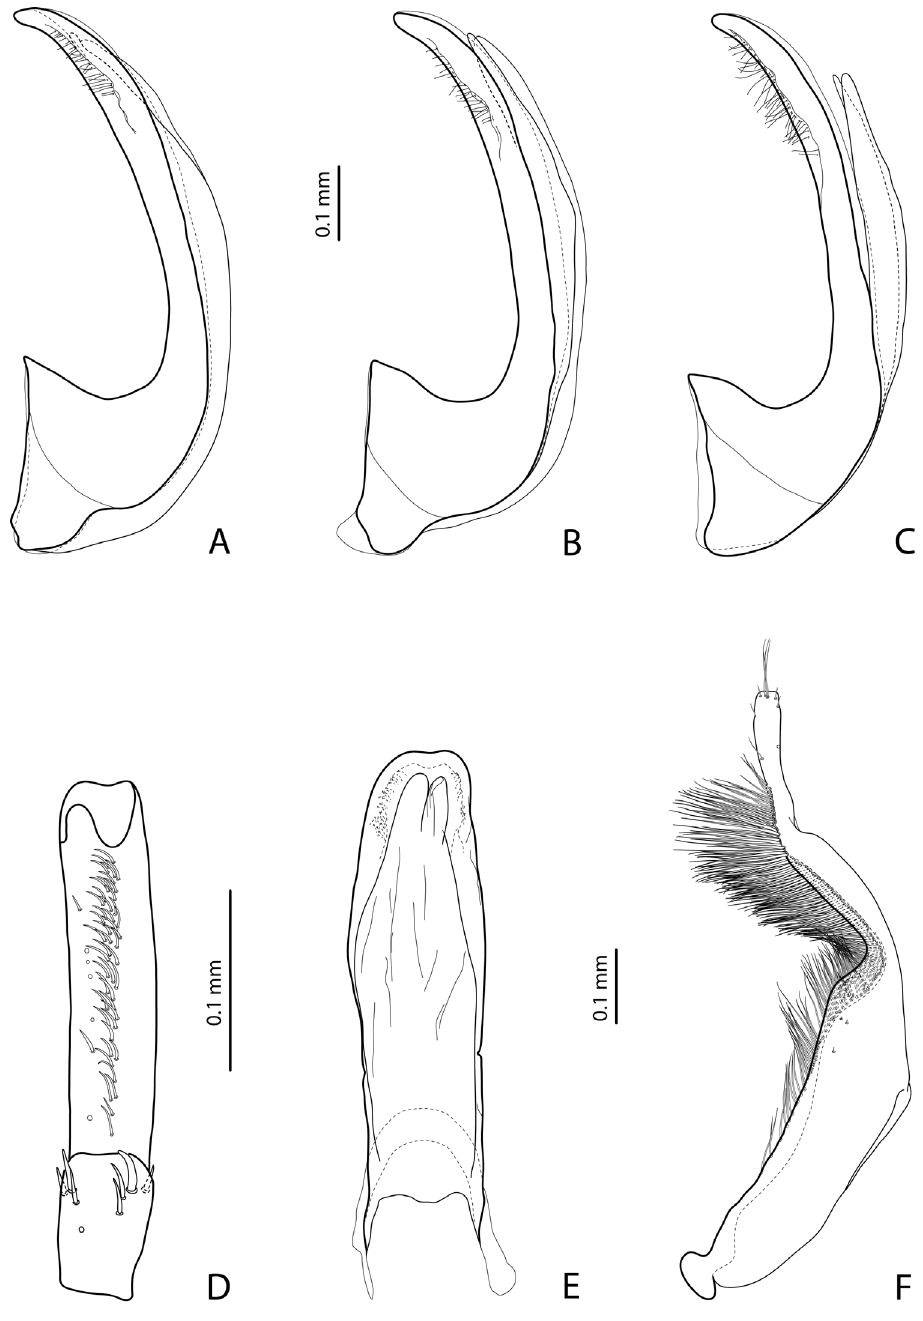
Figure 19. Exocelina danae (Balke, 1998) A–C median lobe in lateral view A paratype of E. danae B paratype of E. tarmluensis (Balke, 1998) C–F PNG, Sandaun, Sokamin4, WB102 D male protar- someres 4–5 in ventral view E median lobe in ventral view F paramere in external